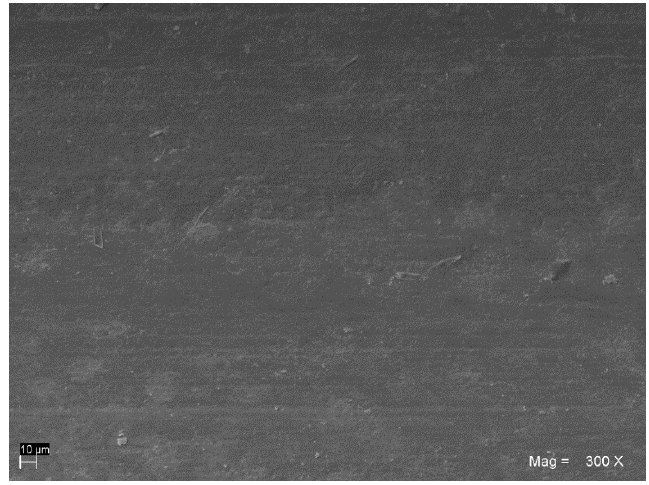
Figure 9. Group 5. The zirconia drill after 50 disinfection cycles with hydrogen peroxide, where no damage was observed on the cutting edges or deposits of other substances.